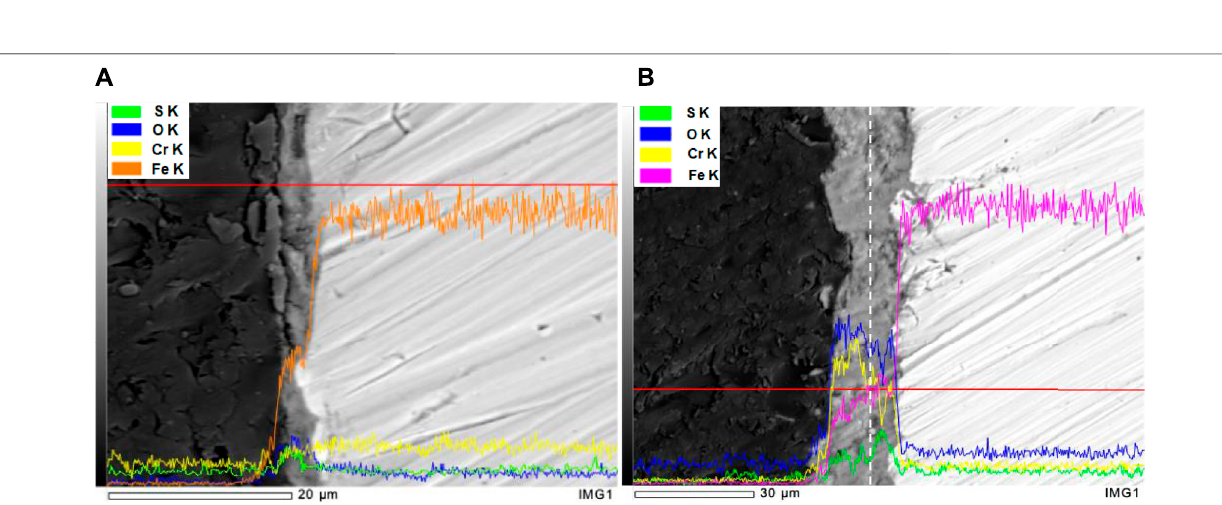
CO 2 -saturated formate fl uids at various immersion times. The selected points were scanned on the outer layer and inner layer after 5, 48, and 120 h of immersion time. The spectrum in Figure 6A indicates that the peak at around 695 cm − 1 is